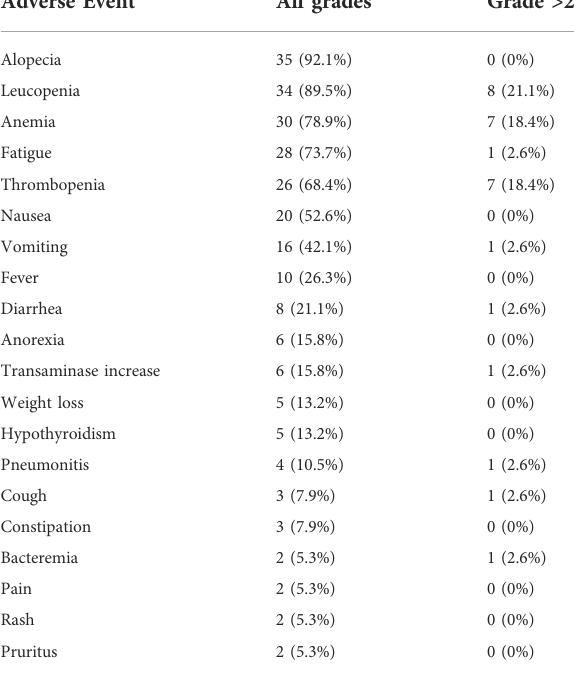
TABLE 4 Adverse